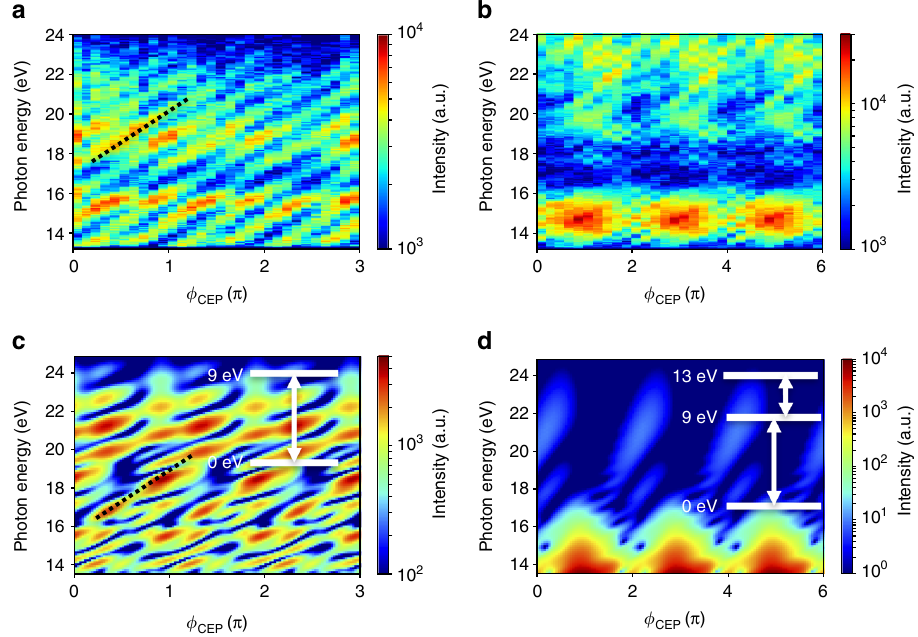
Fig. 3 Dependence of high-harmonic spectrum with carrier-envelope phase of few-cycle pulse. Experimental data for carrier-envelope-phase (CEP) dependence of high-harmonic spectrum from a fused silica and b crystalline quartz at a peak laser fi eld of 2 VÅ − 1 . The dotted black lines trace the change in photon energy of harmonic peaks with CEP. The amplitude of CEP slope is ~3 eV π − 1 . The spectrum of fused silica repeats every π (horizontal axis) while there is a dominant 2 π periodicity for crystalline quartz. The spectral minimum of crystalline quartz persists for all CEP settings. We note that the CEP values in the experiments are relative. c , d show the calculated high-harmonic spectrum from a quantum mechanical simulation of multi-level models. The insets show the respective energy levels and the couplings used in the simulations. The simulation results reproduce the periodicity and CEP slope of the experimental